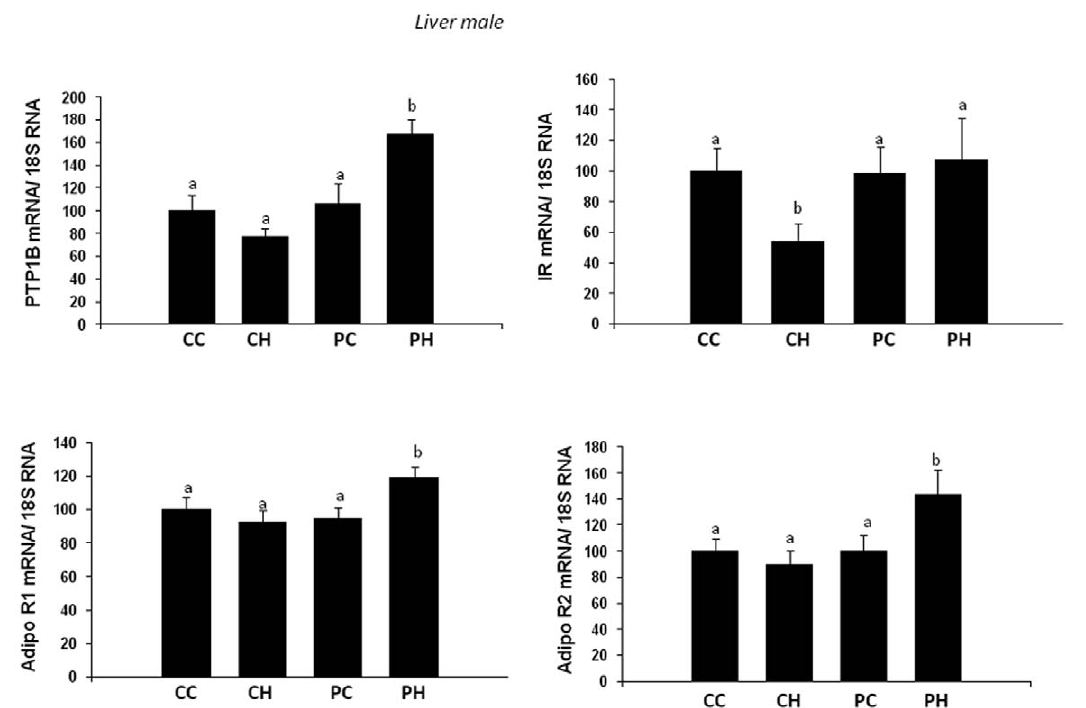
Figure 8. Impact of post weaning diet on hepatic gene expression of male pups born to dams fed the control diet (C) or high-fat diet (HF). At weaning offspring were divided into four groups of each gender (CC, CH, PC, PH; n=10) and named according to the post weaning diet (C or P, first letter) and to maternal diet (C or H, second letter). From weaning to 7 weeks of age all groups were assigned to chow diet then swithched to C or P diet for 13 additional weeks. UCP-2, NPY, POMC and ObRb expression were measured by quantitative RT-PCR and results were normalized to 18S RNA. Different superscript letters a,b denote significant differences at p , 0.05 by ANOVA and the Fisher posthoc test.